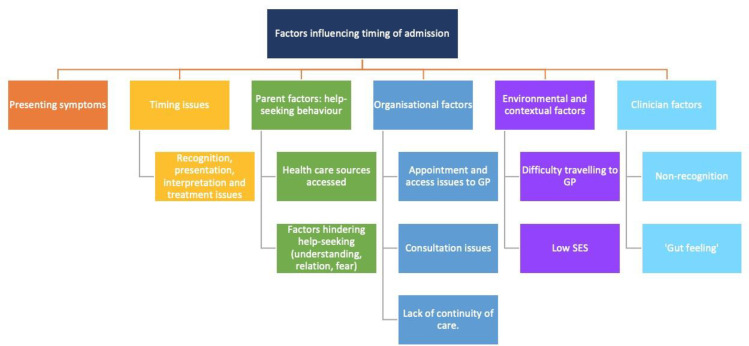
Overview of factors influencing timing of admission.